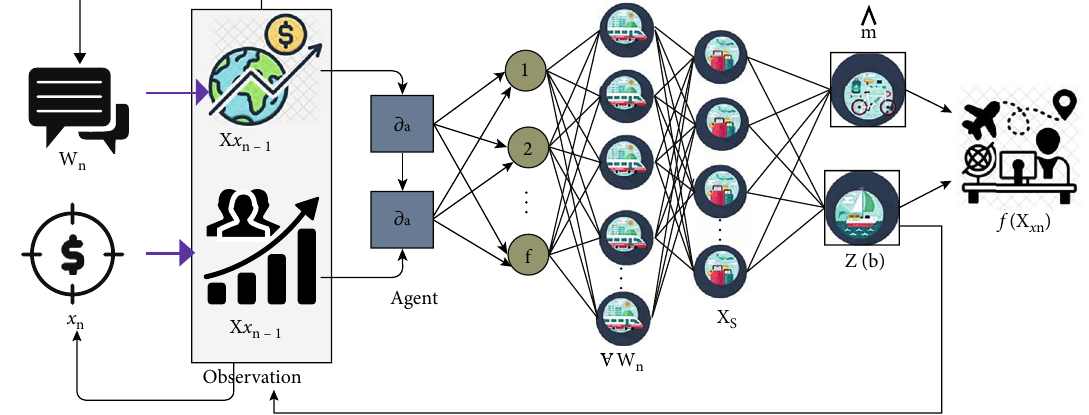
Figure 4: Learning for steep rise or fall.